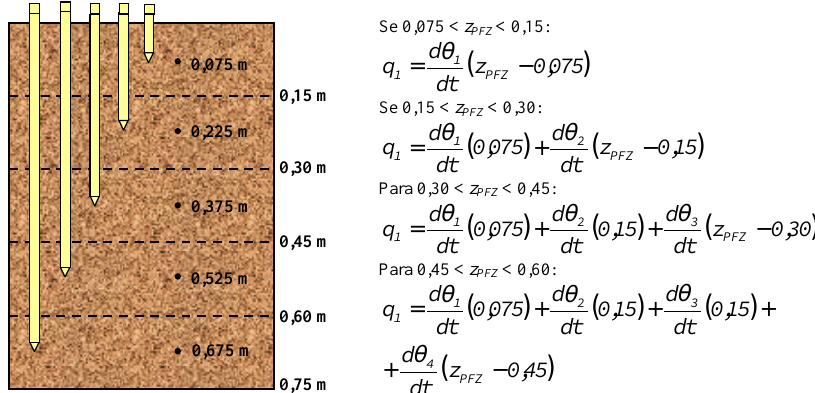
Figura 4. Desenho esquemático do perfil de solo, com as cinco profundidades